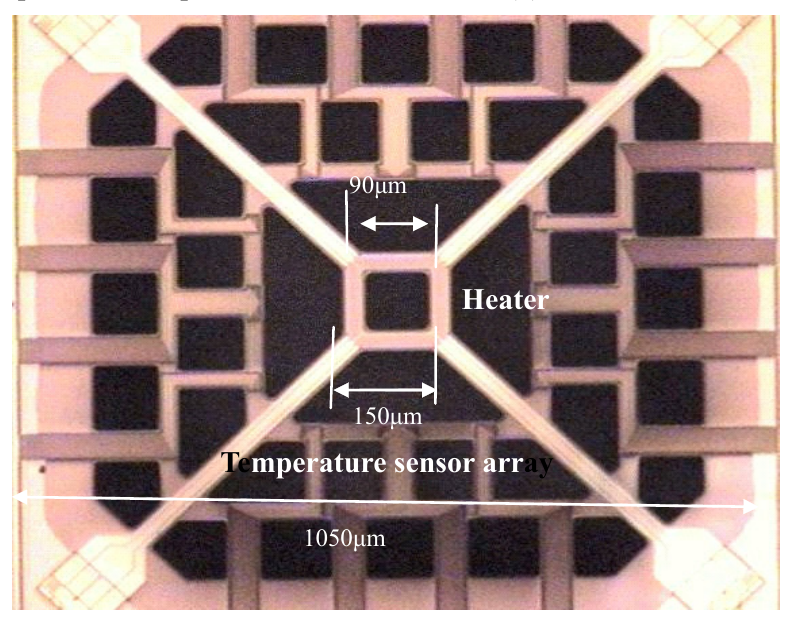
Figure 3. An enlarged photograph of microstructure of the MEMS flow sensor (a) and its working principals for low speed airflow measurement